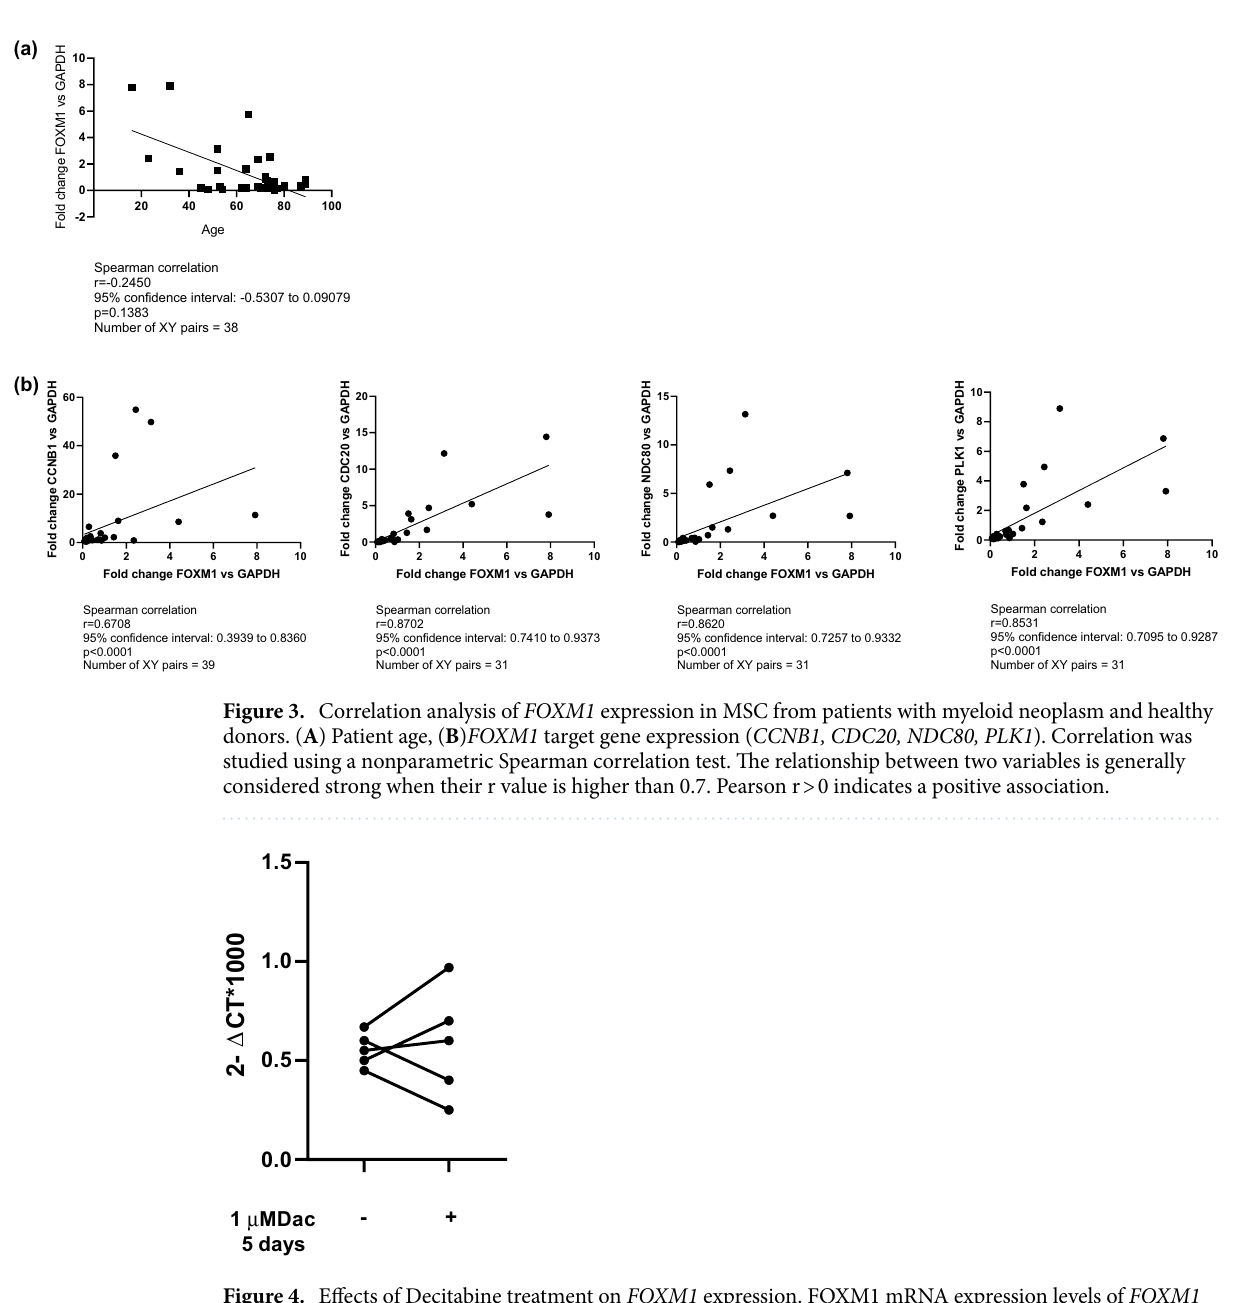
Figure 4. Effects of Decitabine treatment on FOXM1 expression. FOXM1 mRNA expression levels of FOXM1 in P2 BM-MSC isolated from 5 patients with MDS, treated with 1 µM of decitabine for 5 days. FOXM1 expression is presented as 2 −ΔCt × 1000, where ΔCt was Ct ( FOXM1 gene)—Ct ( GAPDH housekeeping gene). The comparison between untreated and treated cells was performed using a nonparametric Wilcoxon matched-pairs signed rank test. * p <